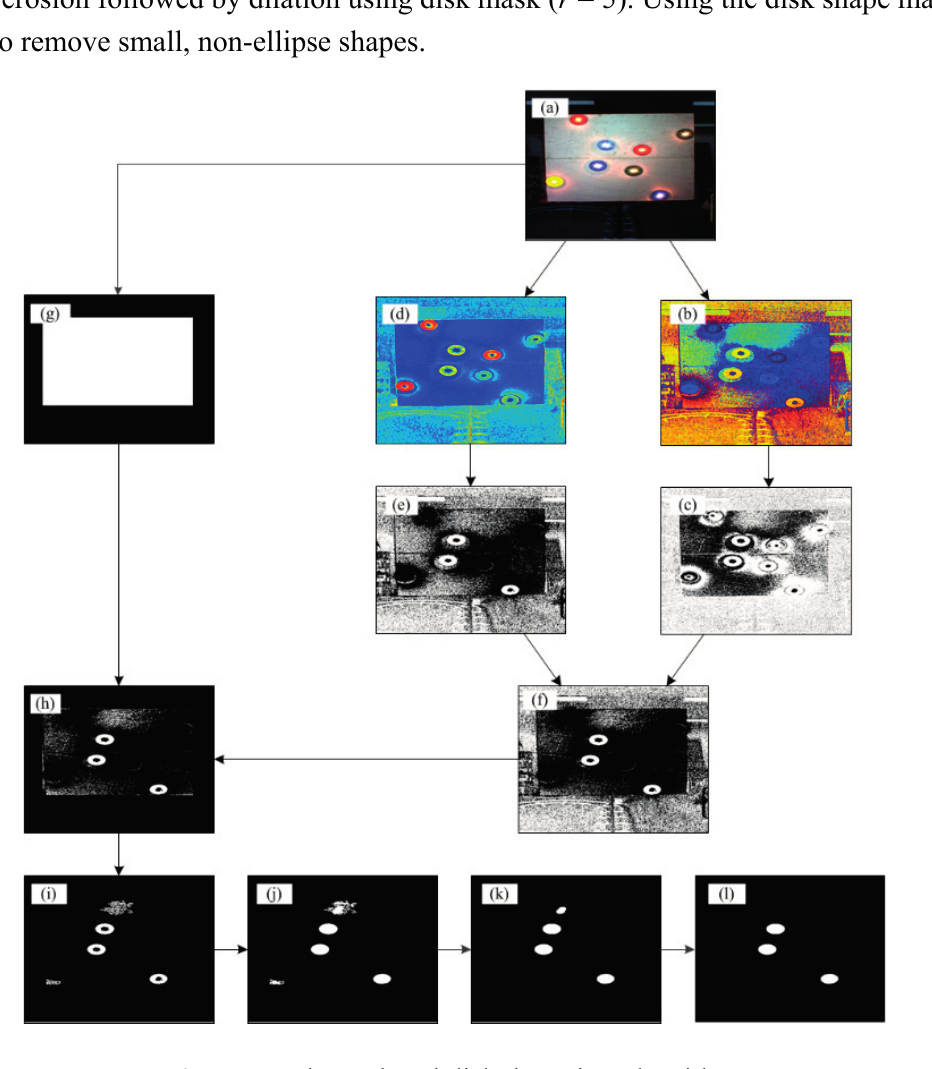
Figure 5. Blue colored disk detection